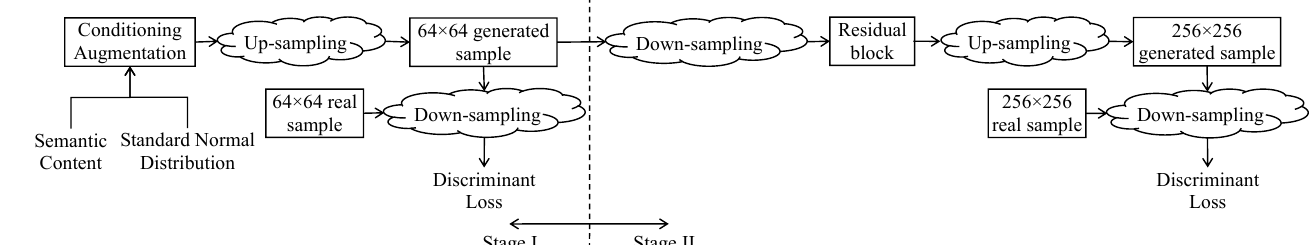
Figure 6. The framework of StackGAN. The generation process is composed of two stages. In Stage I, the generator generates the low-resolution images with rough shapes and colors from semantic content and standard normal distribution. In Stage II, the high-resolution images are formed by fine-tuning according to the results of Stage I.